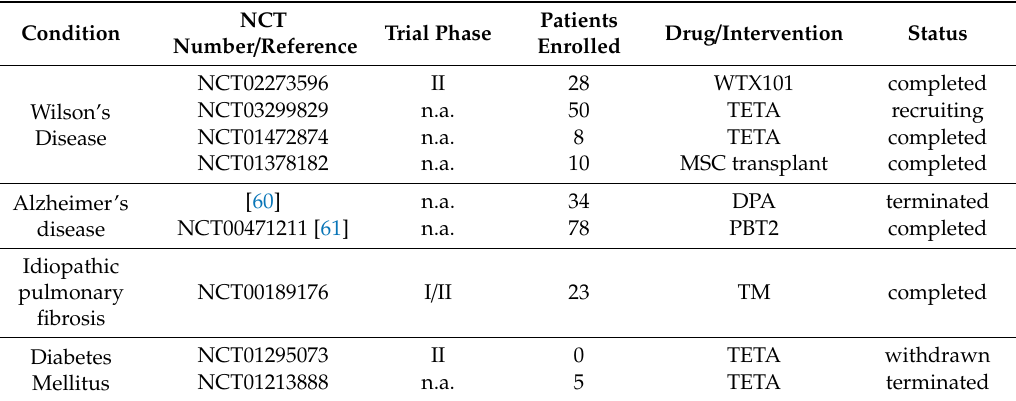
Table 2. Copper chelation therapy clinical trials for non-tumoral